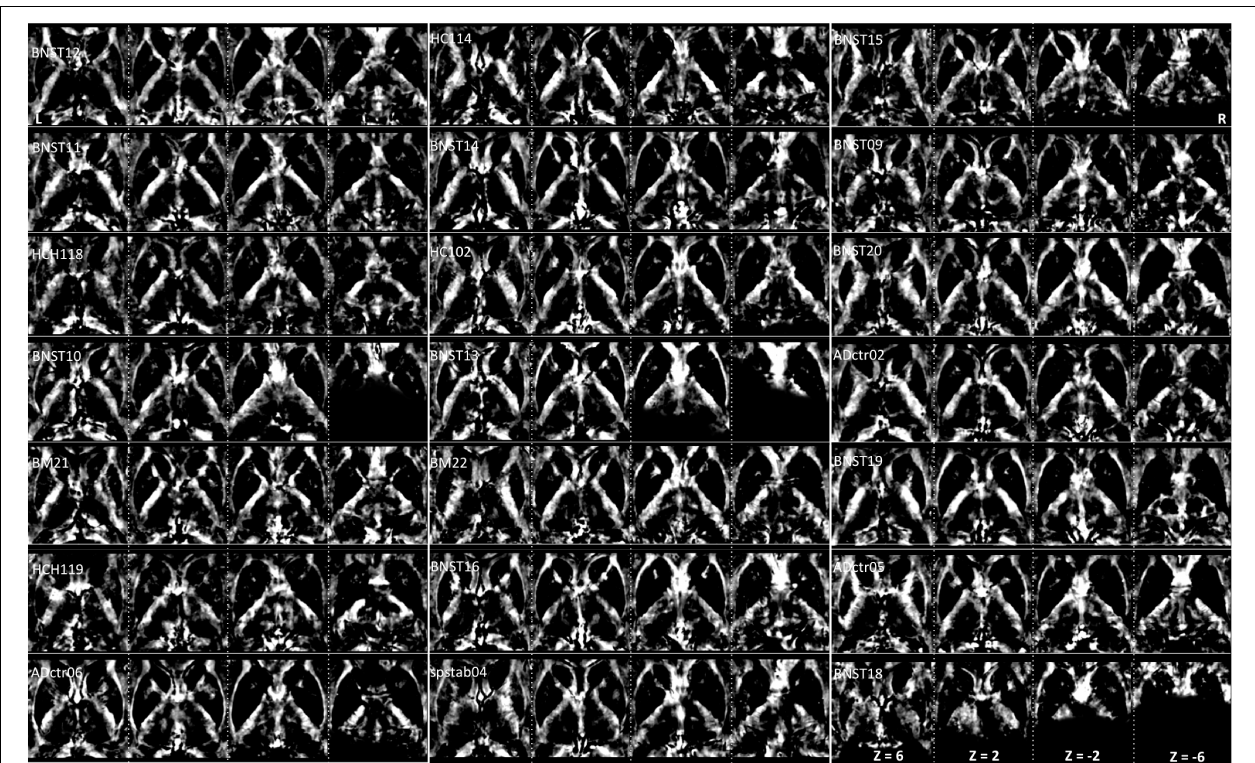
FIGURE 3 | Interindividual maps: QSM images of diamagnetic sources (myelin and calcium, etc.) were obtained from 21 subjects ordered with increasing age. The grayscale color code indicates brighter values in the highly myelinated structures. In the grayscale, brighter values indicate higher and darker lower values. Note the highest values in the internal capsule: Th, NC, PU, and GP display lower values. However, in the quantitative analysis, the difference converges, as the scale of differences in the visualization is heavily biased by the internal capsule fiber contrast. Three subjects (BNST10, BNST13, and BNST18) show only partial